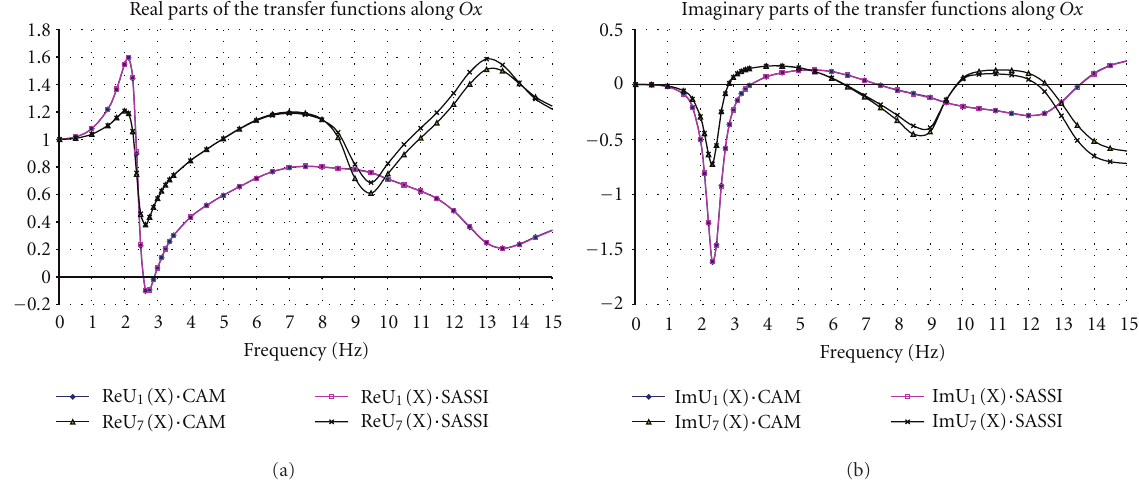
Figure 5: Transfer functions the free-field motion to the motion of the basements along Ox